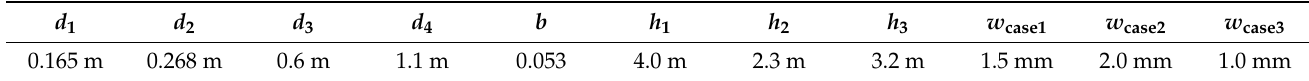
Table 1. The fan